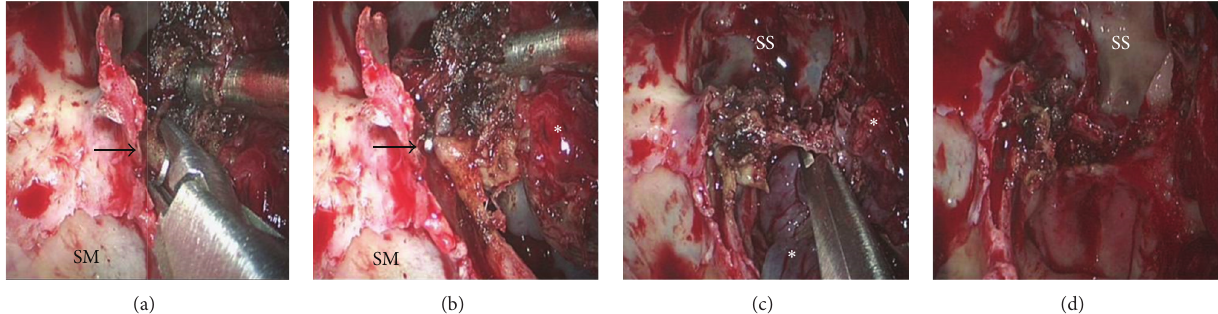
Figure 4: Endoscopically controlled resection. Operation started as a common functional endoscopic sinus surgery including clearing out the ethmoid cells and identifying the frontal sinus and the maxillary sinus. Upon resection of the dorsal part of the septum, a pedicled tumor insertion at the rhinobasis and the lateral nasal wall was found. The tumor’s feeder vessels were exhibited. The vessels originating from the arteria sphenopalatine were specifically identified and clipped ((a), (b); → ). The tumor was completely resected using four hands technique